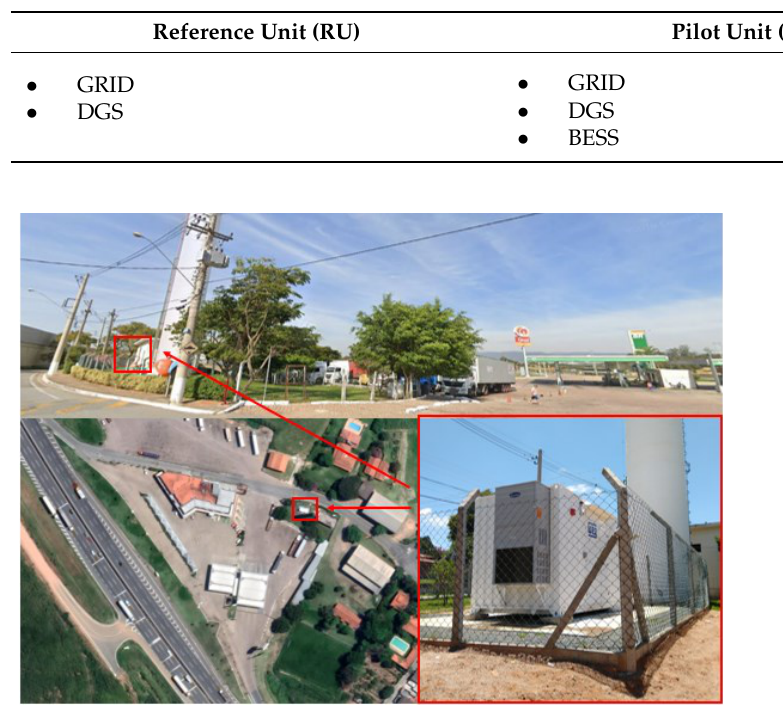
Table 1. Electricity generation resources used in each SS configuration.